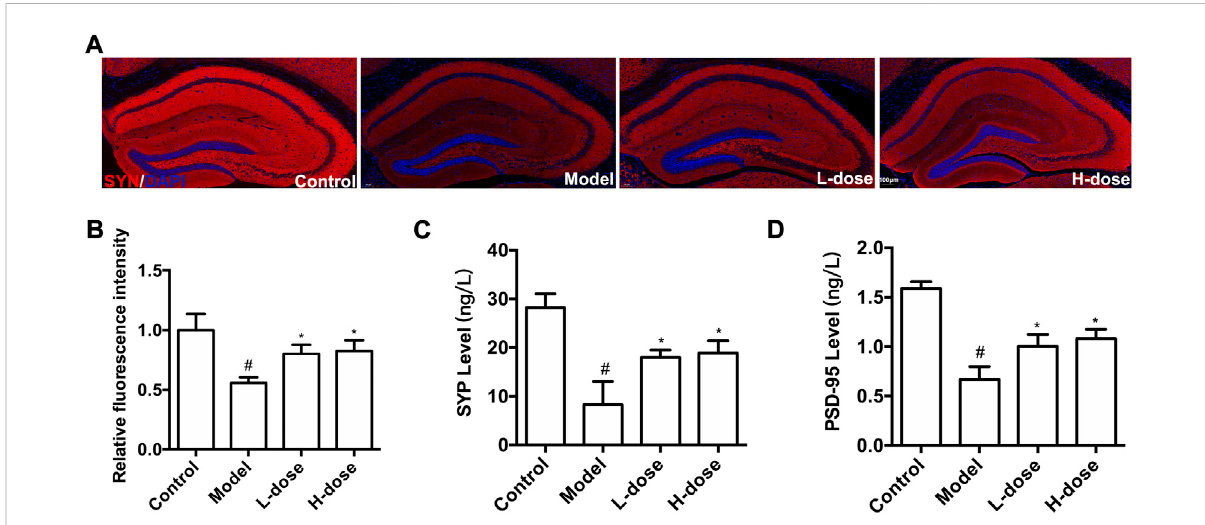
FIGURE 4 BLWE up-regulated the expression of synapse-associated proteins in APP/PS1 mice. Immunocytochemistry staining for SYN-1 (red) and DAPI (blue) in the brain of each group (A) , Scale bar = 100 μ m. Quanti fi cation of the SYN-1 immuno fl uorescence intensity by ImageJ software (B) . Quanti fi cation the concentration of SYP (C) and PSD-95 (D) by ELISA kit. # p < 0.05 vs. the control group; * p < 0.05 vs. the model group. Values are expressed as the mean ± SD ( n = 6 per group).